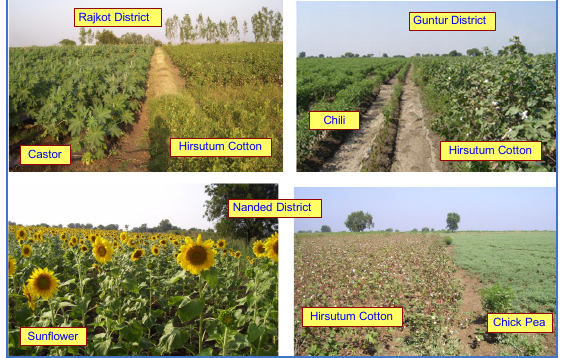
Figure-3 & 4. IRS LISS-III images showing GPS point